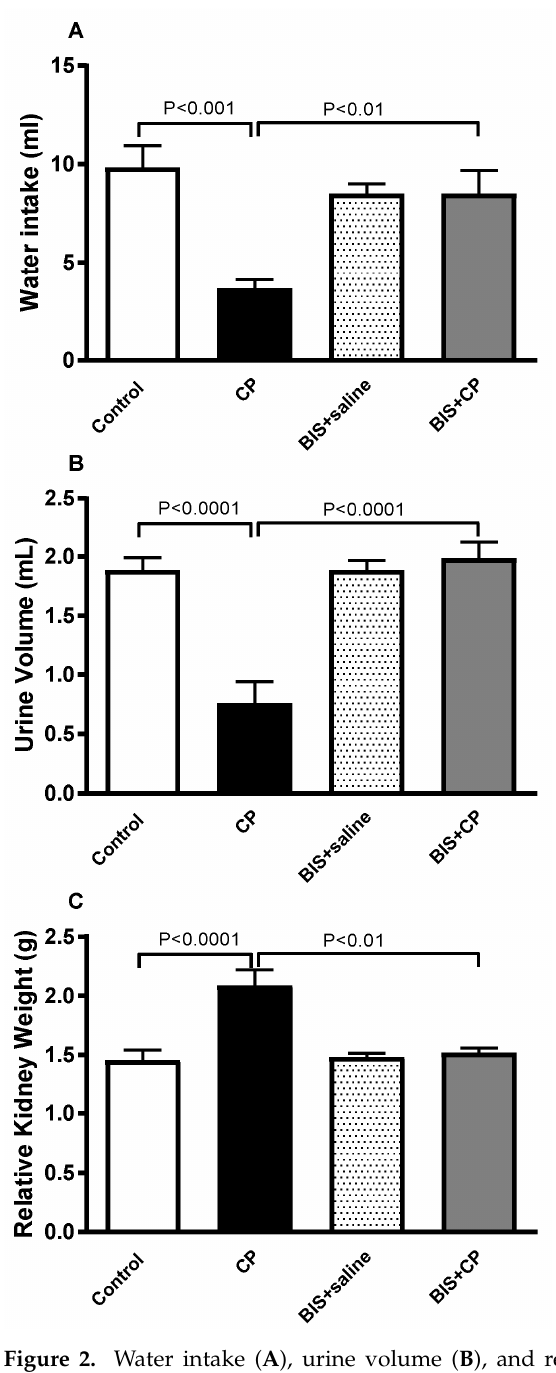
Figure 2. Water intake ( A ), urine volume ( B ), and relative kidney weight ( C ) in mice treated orally with either sunflower oil (control) or bisabolol (BIS, 25 mg/kg) with or without cisplatin (CP, 20 mg/kg) given intraperitoneally (n = 6). Mean ± SEM. Statistical analysis by ANOVA 1 followed by Holm Sidak’s test.